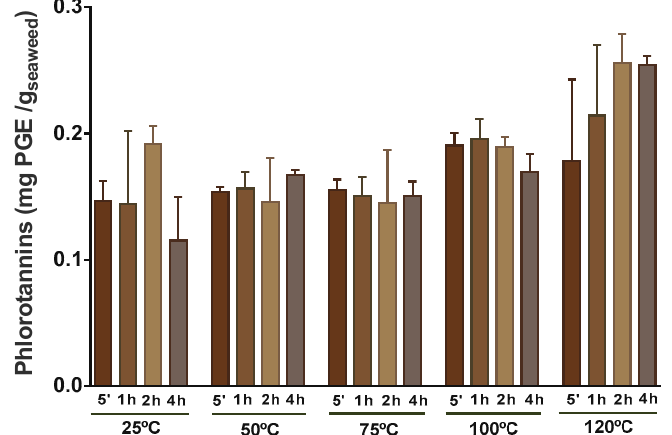
Figure 4. Levels of phlorotannins for extraction at 25, 50, 75, 100, and 120 ◦ C between 5 min and 4 h expressed as mg of phloroglucinol equivalents (PGE) / g of dried seaweed.